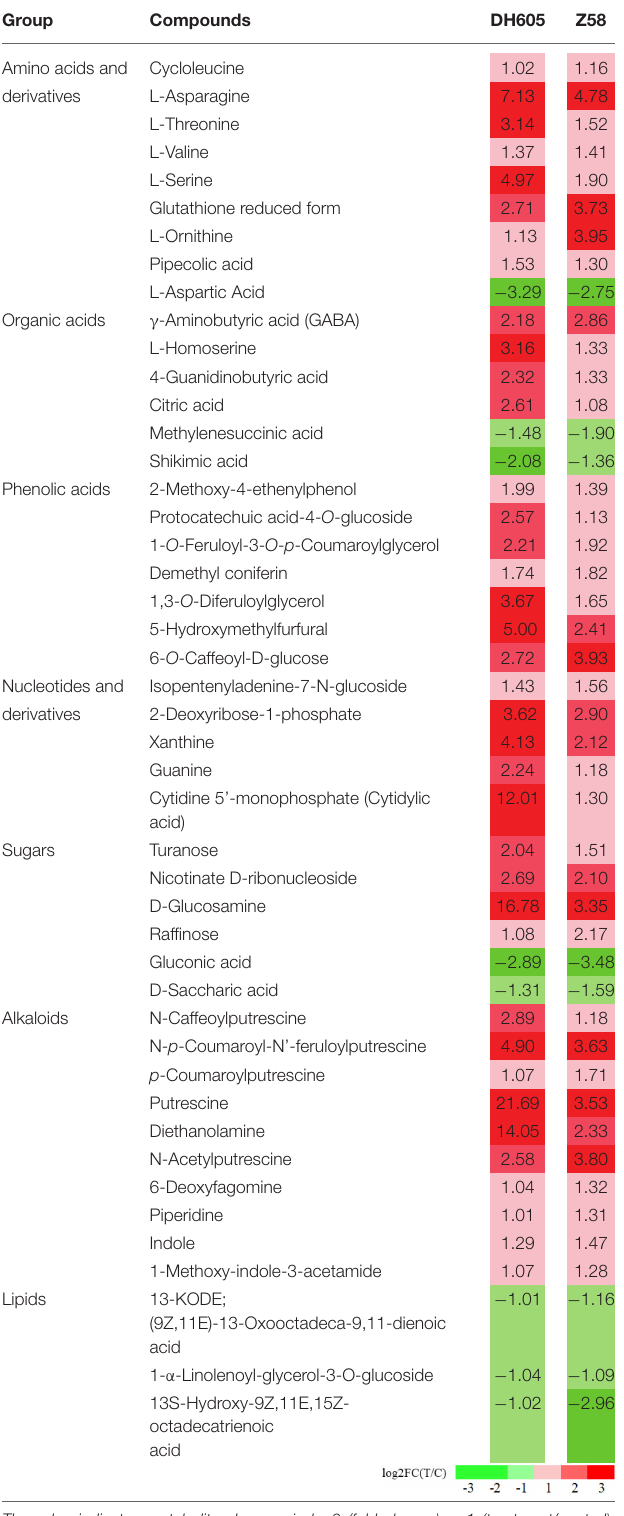
TABLE 2 | Heat-map of metabolite